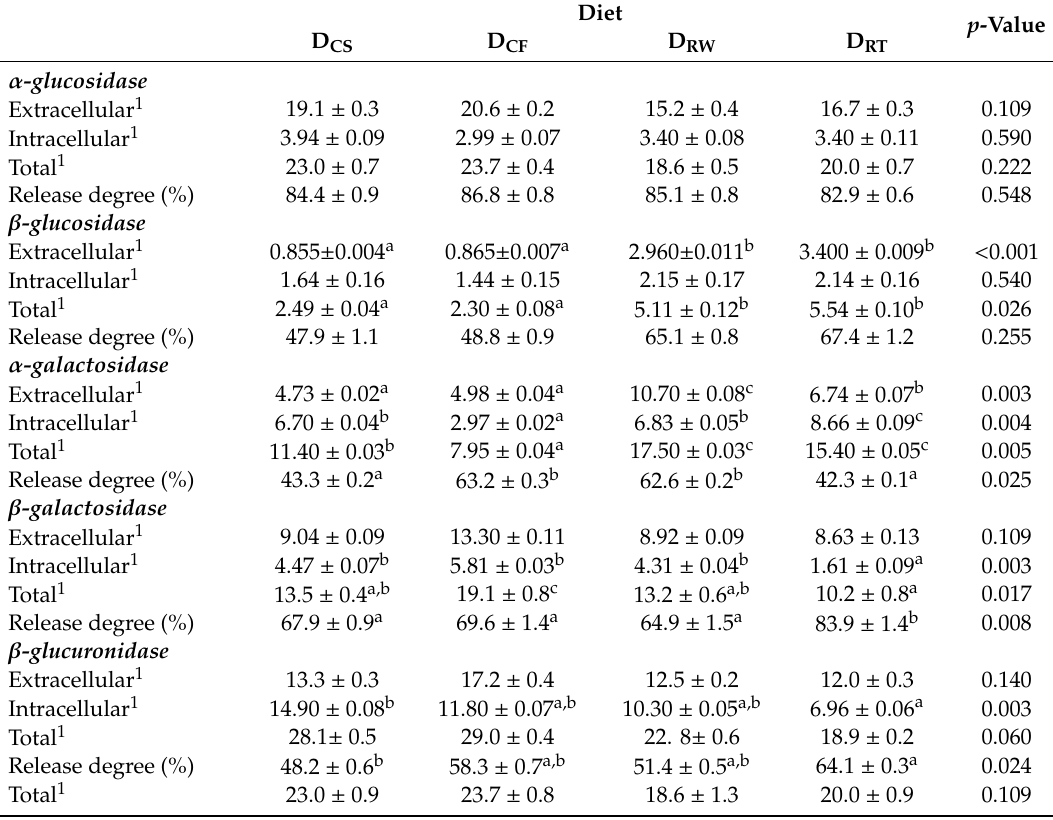
Table 6. Cecal bacterial enzyme activity and their release rate into the intestinal environment in rats fed experimental diets. Data are expressed as mean ± SEM, n =